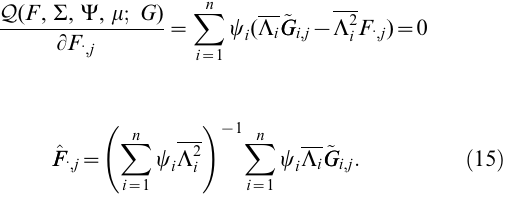
Figure S1 Results of applying SFA, PCA, and ADMIXTURE to the HapMap genotype data after removing half of the Africans. Each plot in the first three columns shows the loadings estimated from the modified data set across individuals. Each plot in the second three columns shows the estimated factors for the original data set against the estimated factors for the modified data set. The first row is SFA, the second row is PCA, and the third row is ADMIXTURE . European individuals are denoted with blue ‘x’s, African individuals are denoted with red triangles, and Asian individuals are denoted with green ‘ + ’s. A dashed horizontal line is at zero on the y-axis. Note how the correlation of the two unaffected populations for SFA and ADMIXTURE is much higher than for any of the factors in PCA. Figure S2 Results from PCA, SFA, and ADMIXTURE for the Indian data. Only one estimated loading from SFA and ADMIX- TURE are shown because the second set of loadings are perfectly negatively correlated to the first. The results from SFA are almost identical to those from PCA for these data. The individuals are colored as in the map from Figure 10 in the main text according to their population